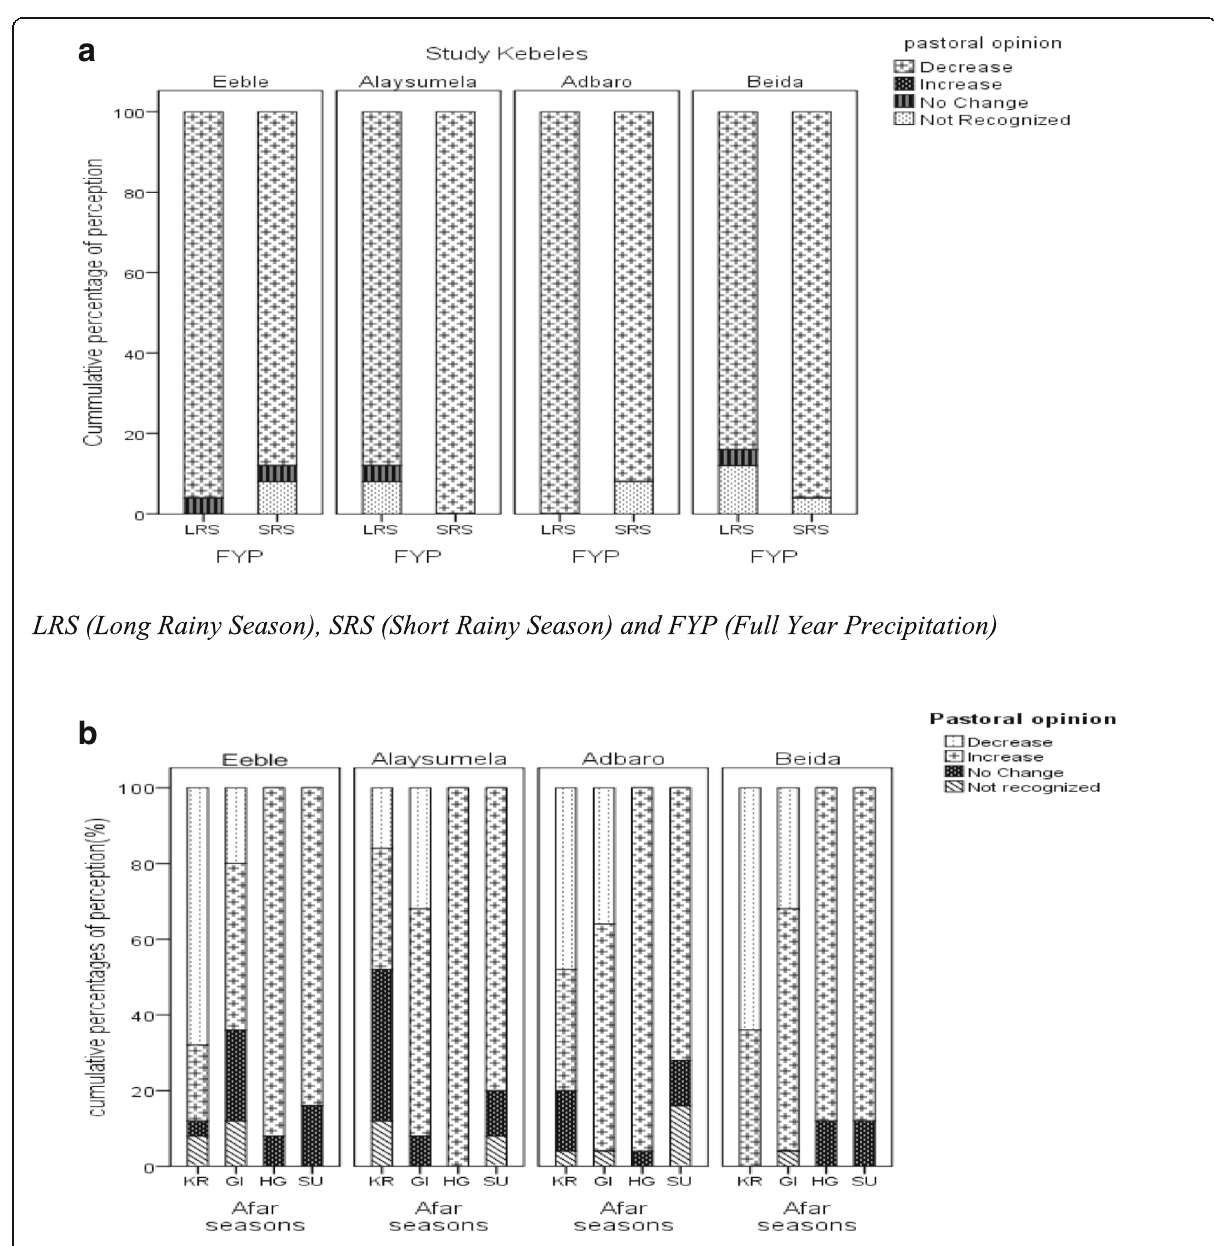
Fig. 3 a Percentage of pastoral perception in relation to change in precipitation in the last three regimes. b Percentage of pastoral perception in relation to change in temperature in the last three Ethiopian